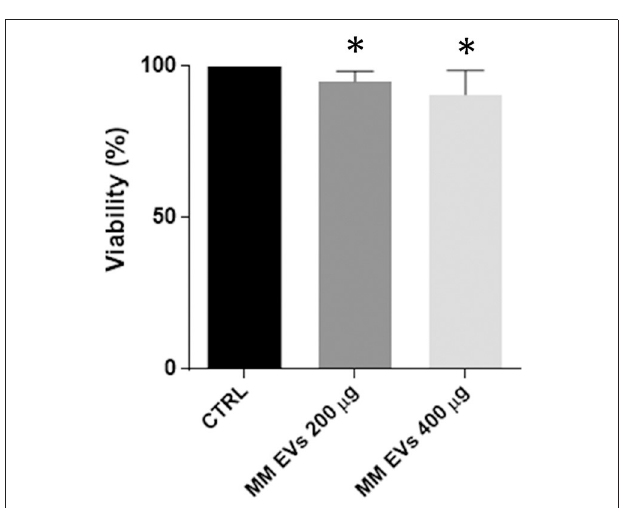
FIGURE 2 | MM-EV effect on HSPC viability. HSPC viability after 20h of treatment with 200 µ g and 400 µ g of MM-derived EVs. Results are expressed as the percent of cell viability normalized to control. The bar graphs represent the average with standard deviation from three independent experiments; * indicates p < 0.05. MM, multiple myeloma; EVs, Extracellular vesicles; HSPC, hematopoietic stem and progenitor